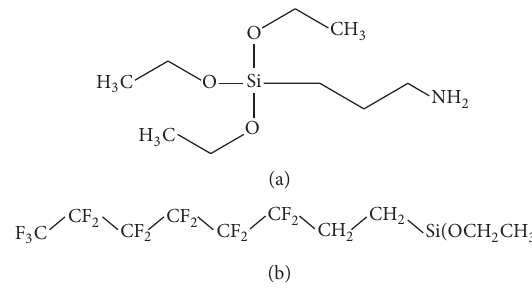
Figure 2: Silane compound constitutional formula: (a) 3-aminopro- pyltriethoxysilane; (b) tridecafluoro-1,1,2,2-tetrahydrooctyl-1-trie-